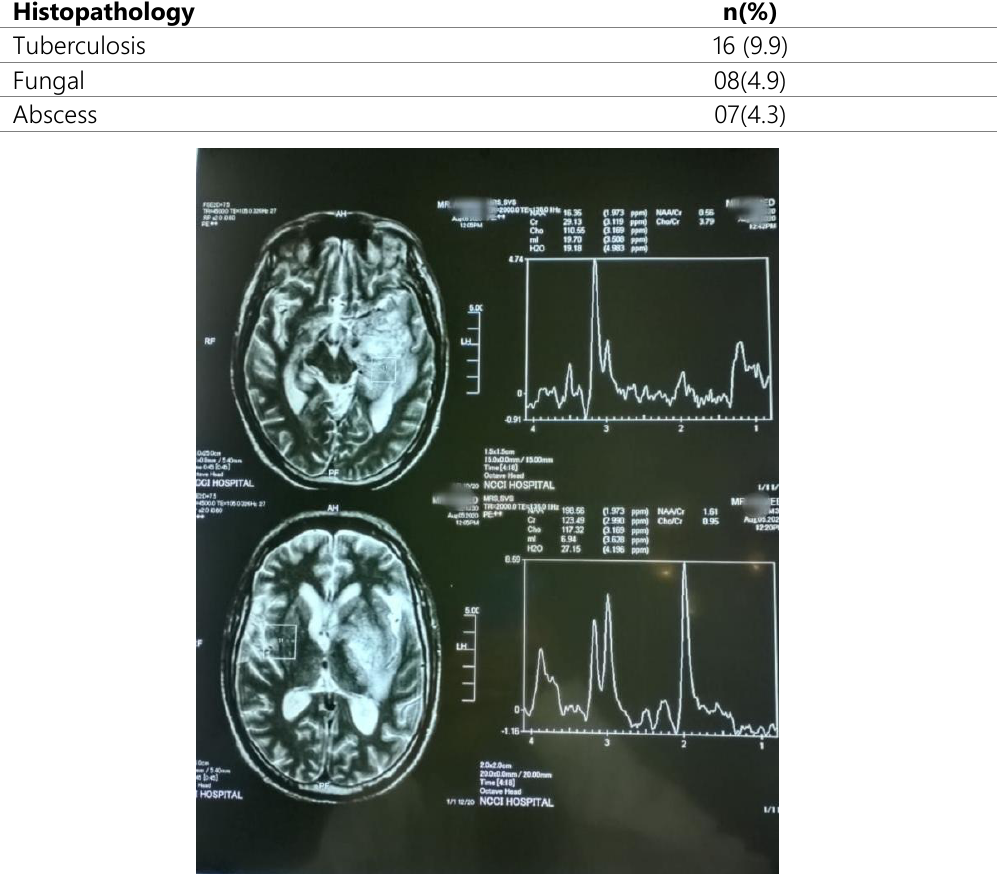
Figure 1: Image showing different components of chemical analysis of the specific case included in the